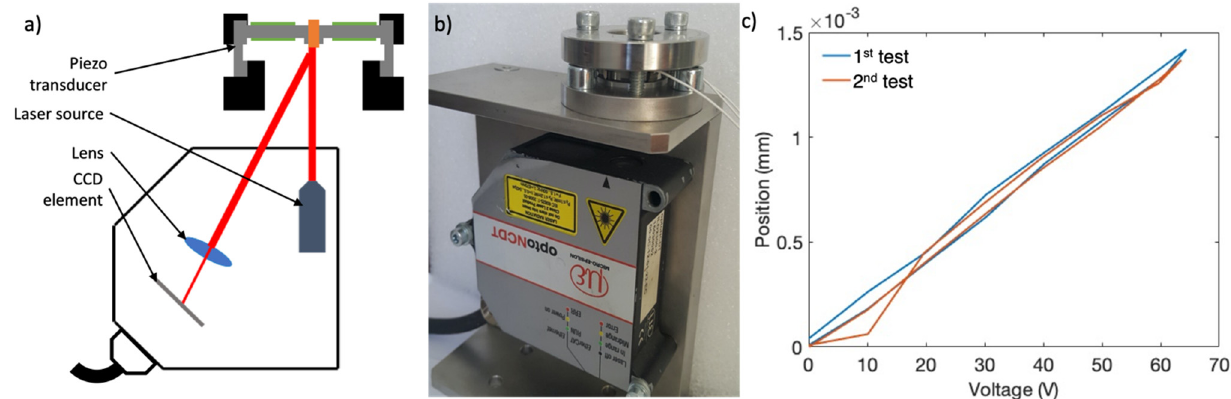
Figure 5. Schematics and results of the laser measuring technique. ( a ) Schematics of the laser triangulation; ( b ) image of piezo transducer test bench; and ( c ) piezo control voltage–CCD position figure.